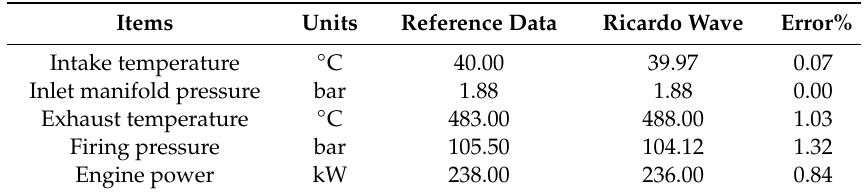
Table 3. Comparison between reference data and calculated results from Ricardo Wave at 50% engine load.